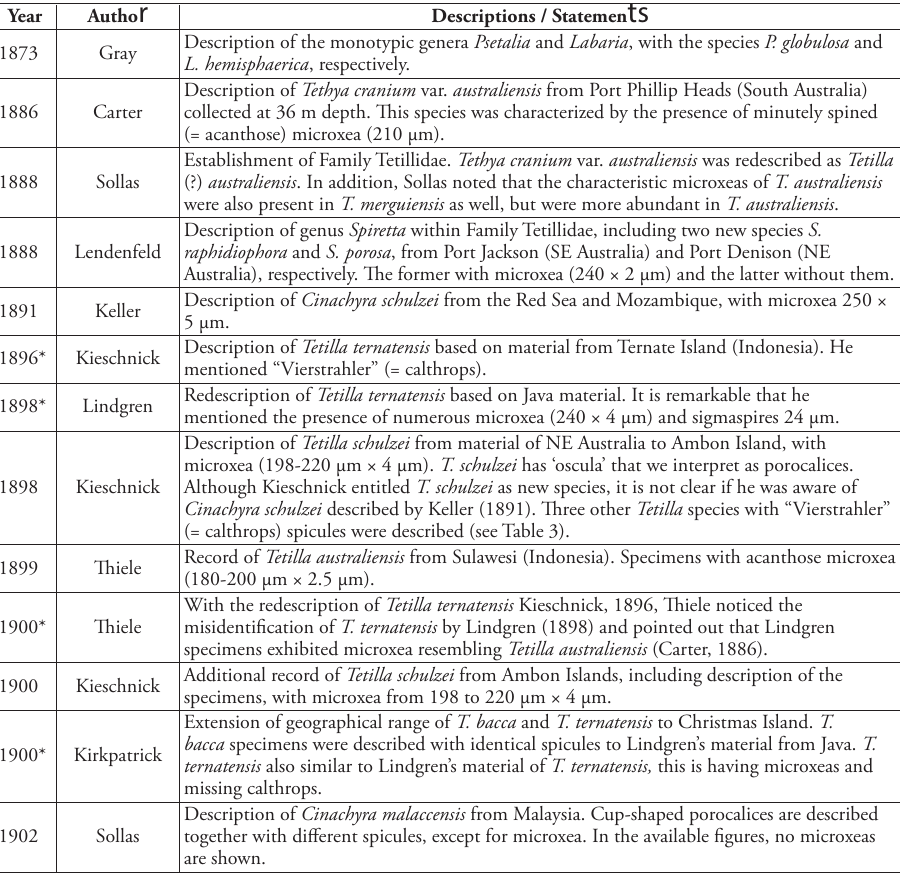
Table 5. Historic milestones in the taxonomy of Cinachyrella australiensis and other Cinachyrella species from Indonesia. Asterisk (*) indicates misidentification of Cinachyrella specimens as Paratetilla